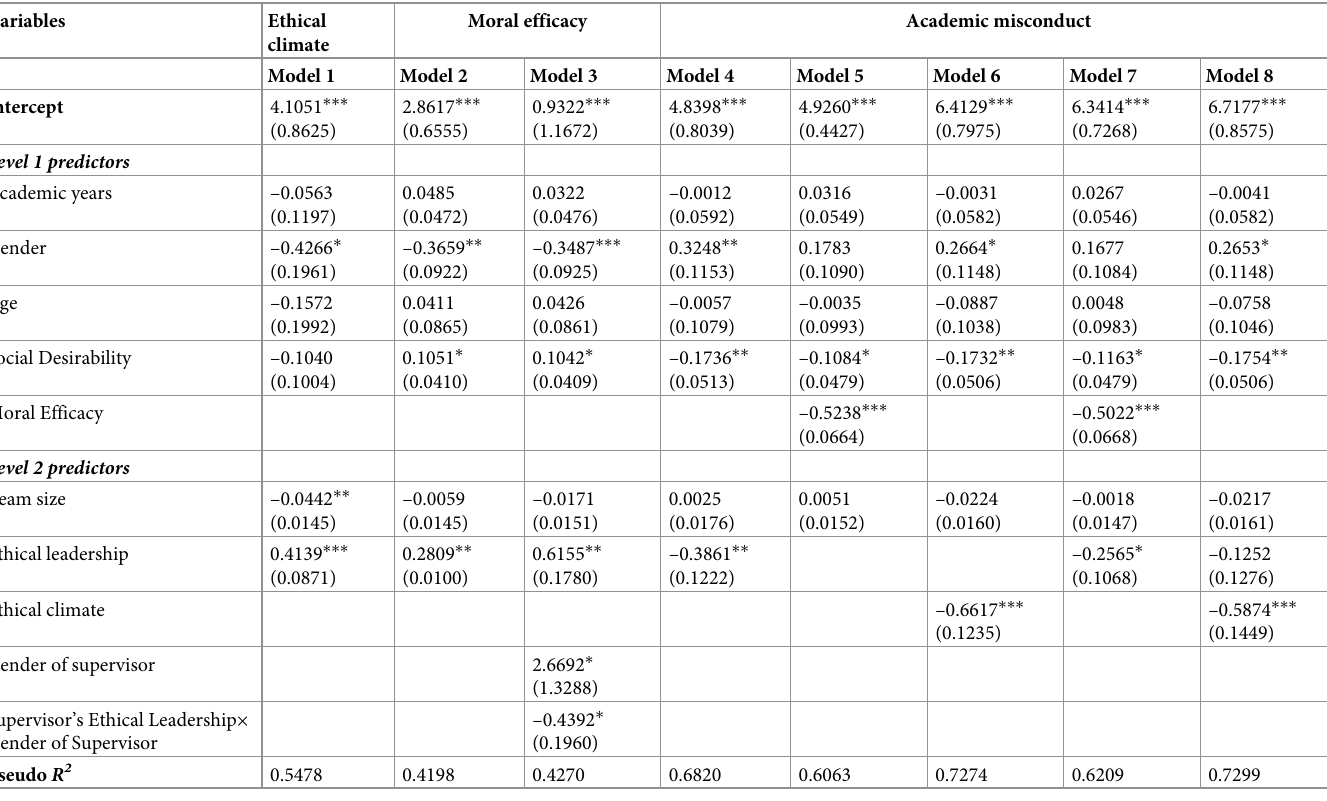
Table 2. Regression results using ethical climate, moral efficacy, and academic misconduct as dependent